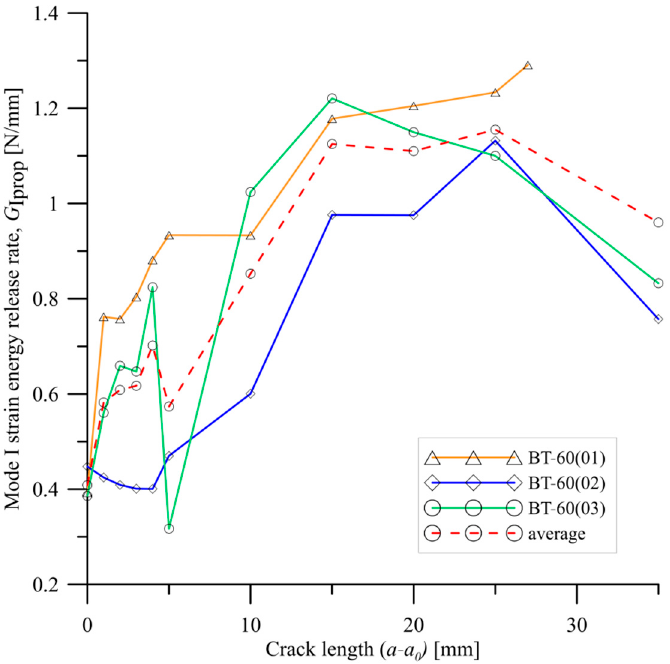
Figure 11. R -curves obtained for the BT60 laminates.